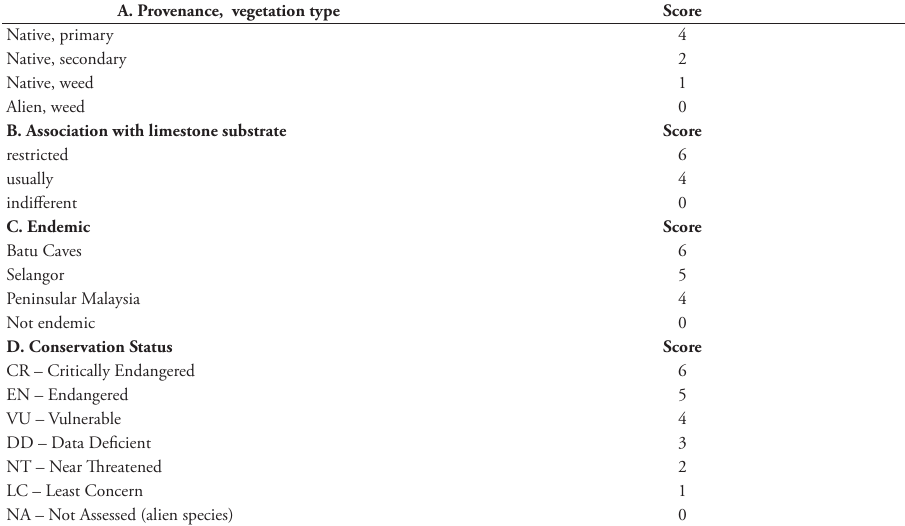
Table 4. Criteria for assigning the conservation importance score (CIS) to species, based on scores for provenance, vegetation type, status as a limestone species, endemism and conservation status, based on IUCN Categories.